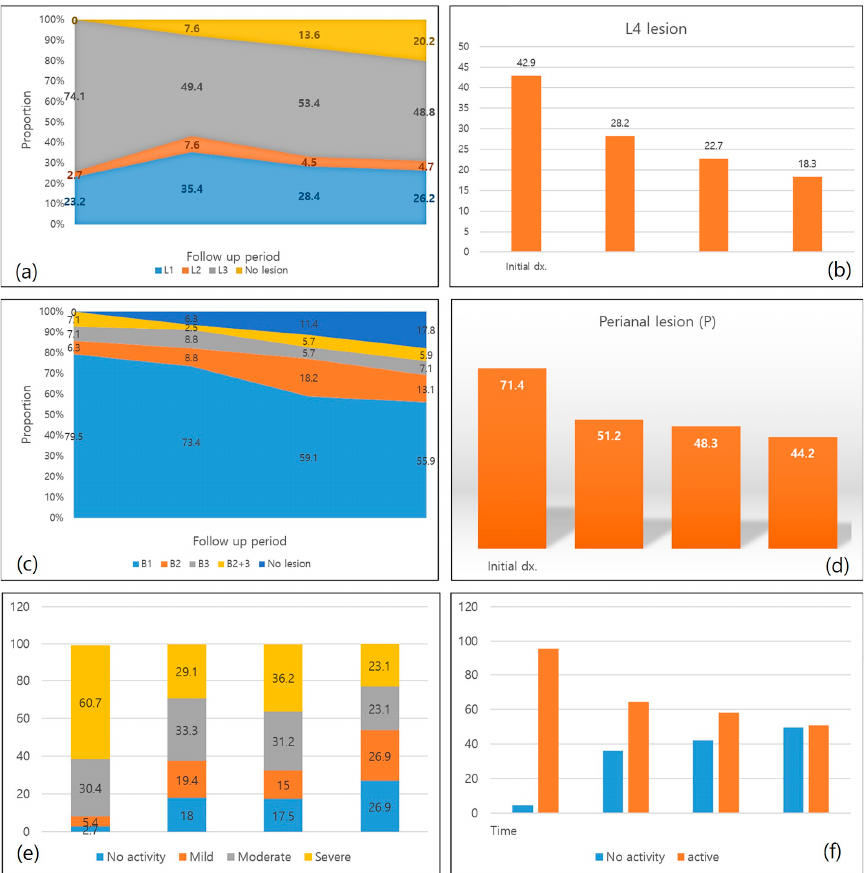
Figure 2. Changes in disease pattern. ( a ) Disease location from initial diagnosis to the last follow up; ( b ) percentage of presence of L4 lesion (upper gastrointestinal tract involvement); ( c ) disease behav- ior from initial to the last follow up; ( d ) percentage of perianal disease; ( e ) disease activity evaluated on CT images; ( f ) disease activity evaluated on endoscopy. Comparison of clinical and disease characteristics between well-controlled and unfa- vorable disease course The mean age of the study population was 24.73 ± 9.4 (range, 12–51) years, and 82.1% (92/112) of patients were male. Systemic steroids were used in only 5.4% (6/112) of patients at the initial visit. The regimen for the induction of remission was either steroid with or without sulfasalazine (80.4%) or biologics (infliximab or adalimumab, 19.6%). Most of the patients received immunosuppressants (IS) (96.4%, 108/112), more than one type of